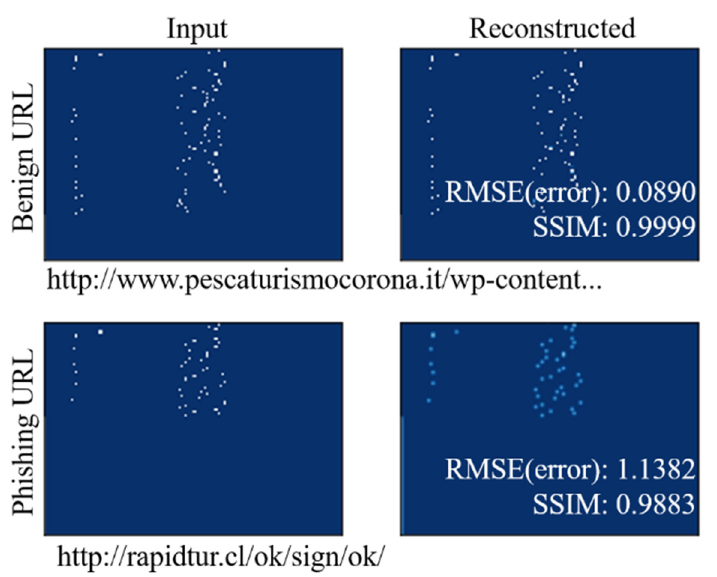
Figure 8. Comparison of the URL and its reconstructions with benign and phishing URLs.